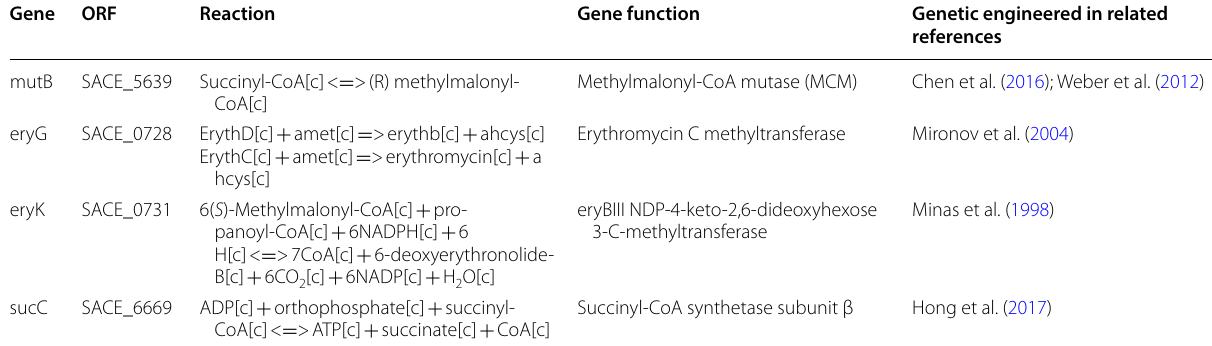
Table 4 The knockout targets which have been validated in our lab and on other published